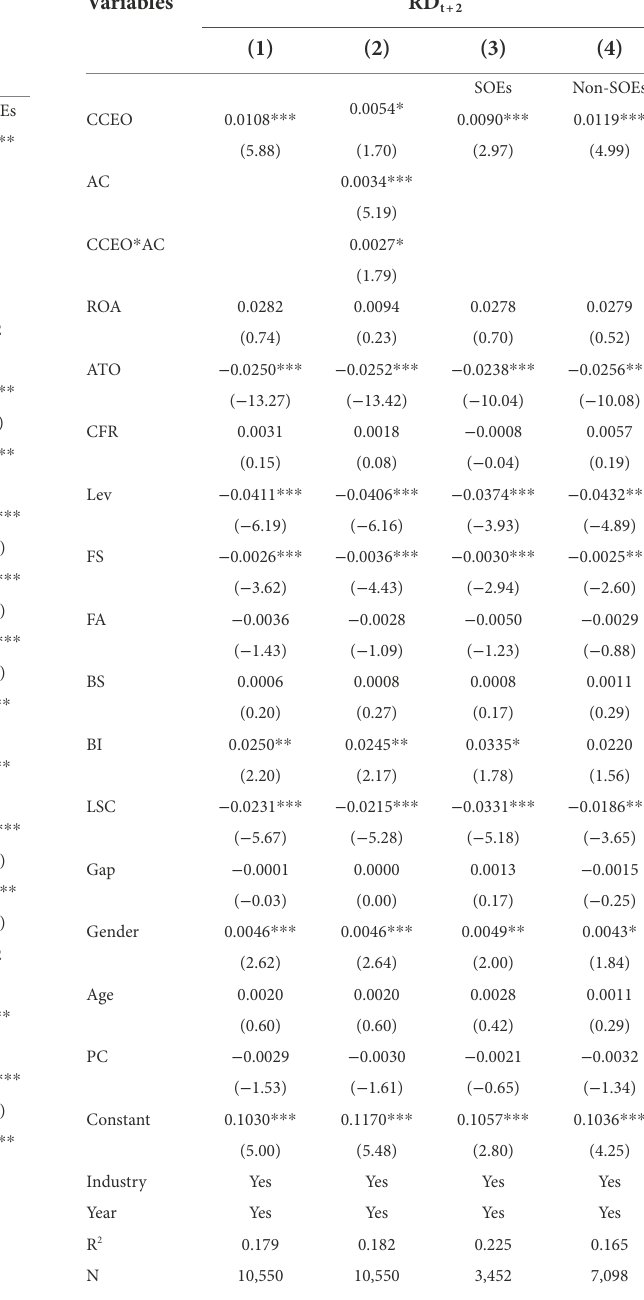
TABLE 8 Robustness test: Additional lagged